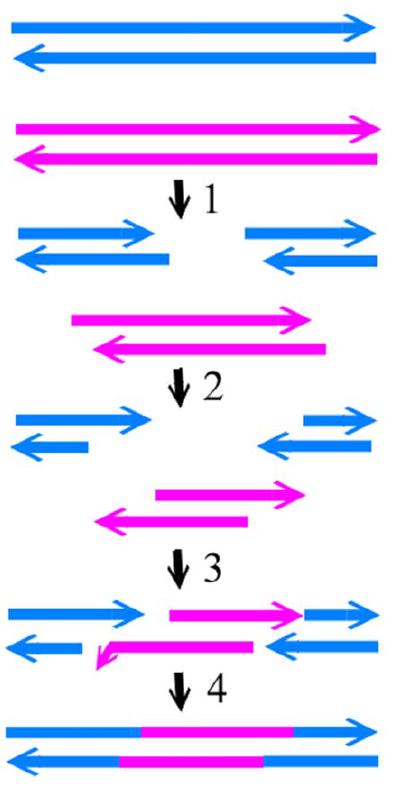
Figure 6. The mechanism of endonucleolytic cleavages at nonequivalent sites and strand annealing (CNSA). Colors and arrows are the same as those of Figure 5. The steps are: 1, production of DSBs by cutting at nonequivalent sites of T3 and T7 DNA; 2, 5 9 resections of DSBs of T3 and T7; 3, annealing of the T3 DSBs with the T7 DSB; 4, removal of the nonhomologous nucleotides, filling the gap, and ligation.